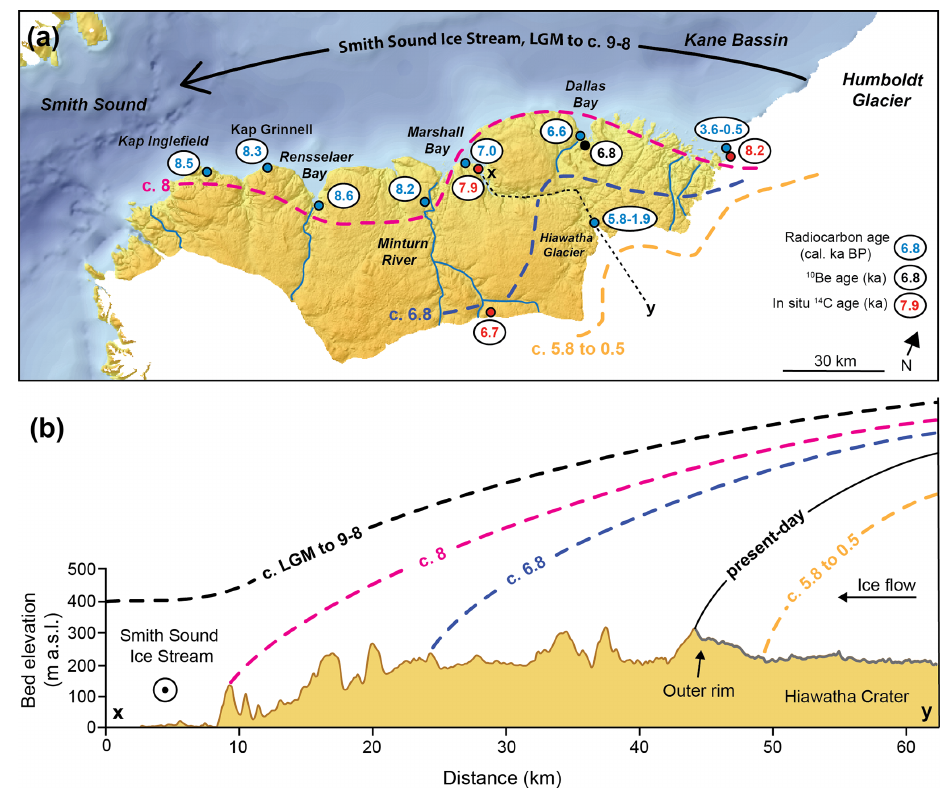
Figure 7. Deglaciation in Inglefield Land. Panel (a) shows ages believed to constrain the deglaciation in the area. In situ 14 C ages and radiocarbon ages at Humboldt Glacier and Hiawatha Glacier are from this study. Radiocarbon ages at the coast are from Nichols (1969), Blake et al. (1992) and Mason (2010). Panel (b) shows the Holocene deglaciation pattern in Inglefield Land inferred from this study across the transect ( x – y ) seen in panel (a)